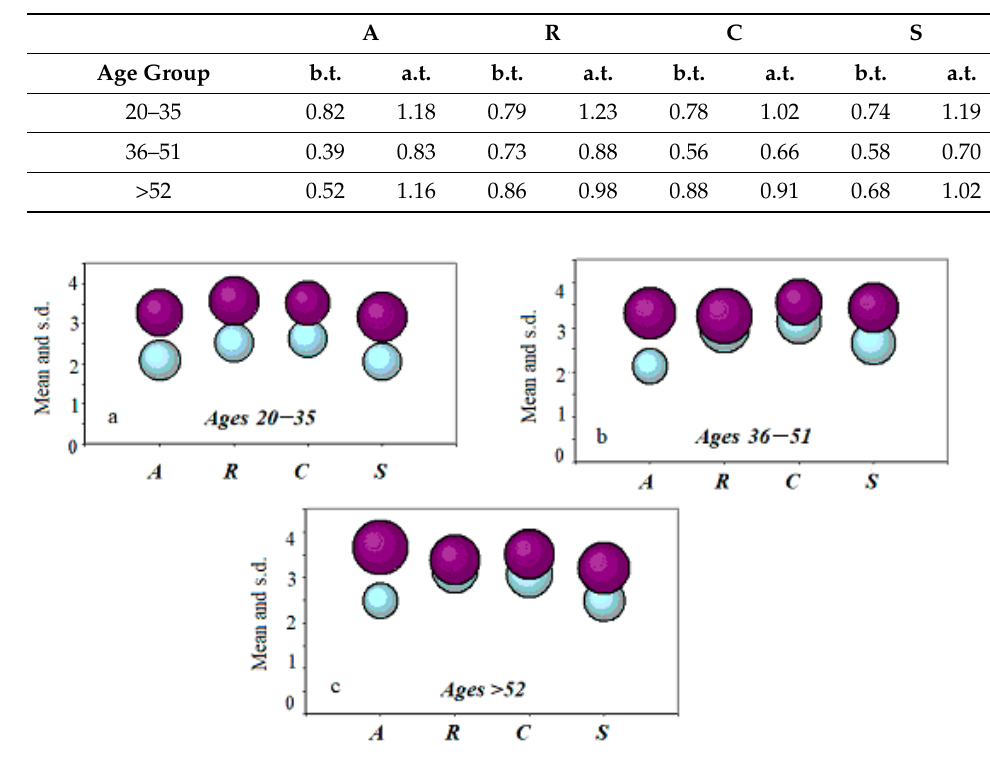
Figure 2. Mean score and the standard deviations per age group, for all questions, for the factors of Attention (A), Relevance (R), Confidence (C) and Satisfaction (S) of the ARCS model, before training (lower row) and after training (upper row). The diameter of each ball is proportional to the standard deviation: 20–35 ( a ), 36–51 ( b ), >52 ( c ).